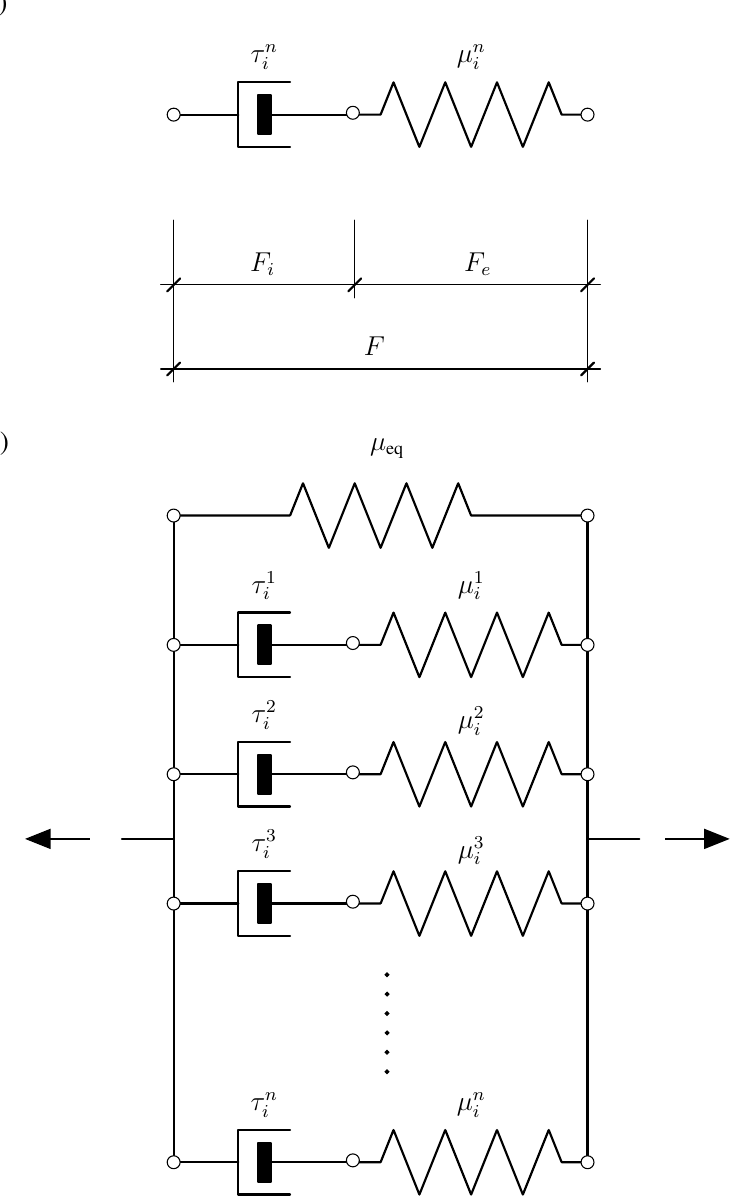
Figure 3. ( a ) Rheological model of the Maxwell body and ( b ) Representation of the rheological model for a generalized Maxwell (Maxwell-Zener) body with n Maxwell branches connected in parallel for description of the viscoelastic properties of